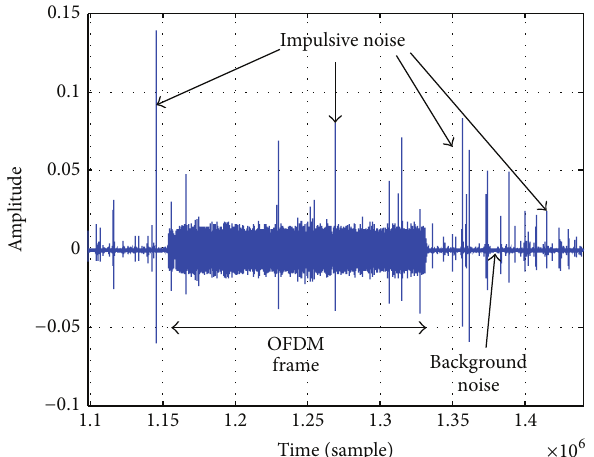
Figure 3: Received signal with many Impulsive Noise